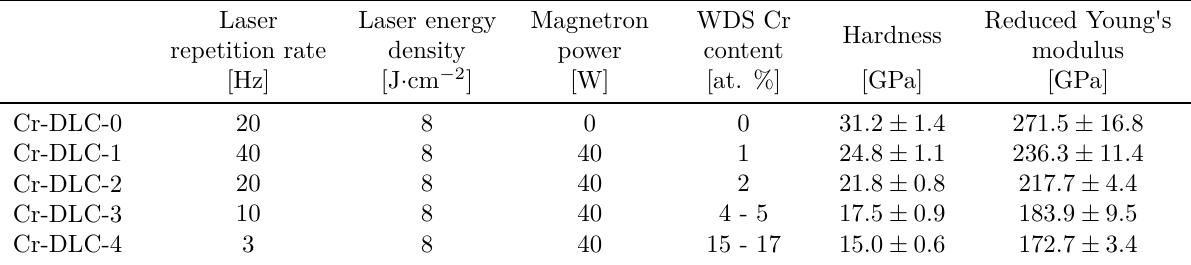
Table 1. Deposition parameters, chromium content and mechanical properties of DLC and Cr doped DLC layers.